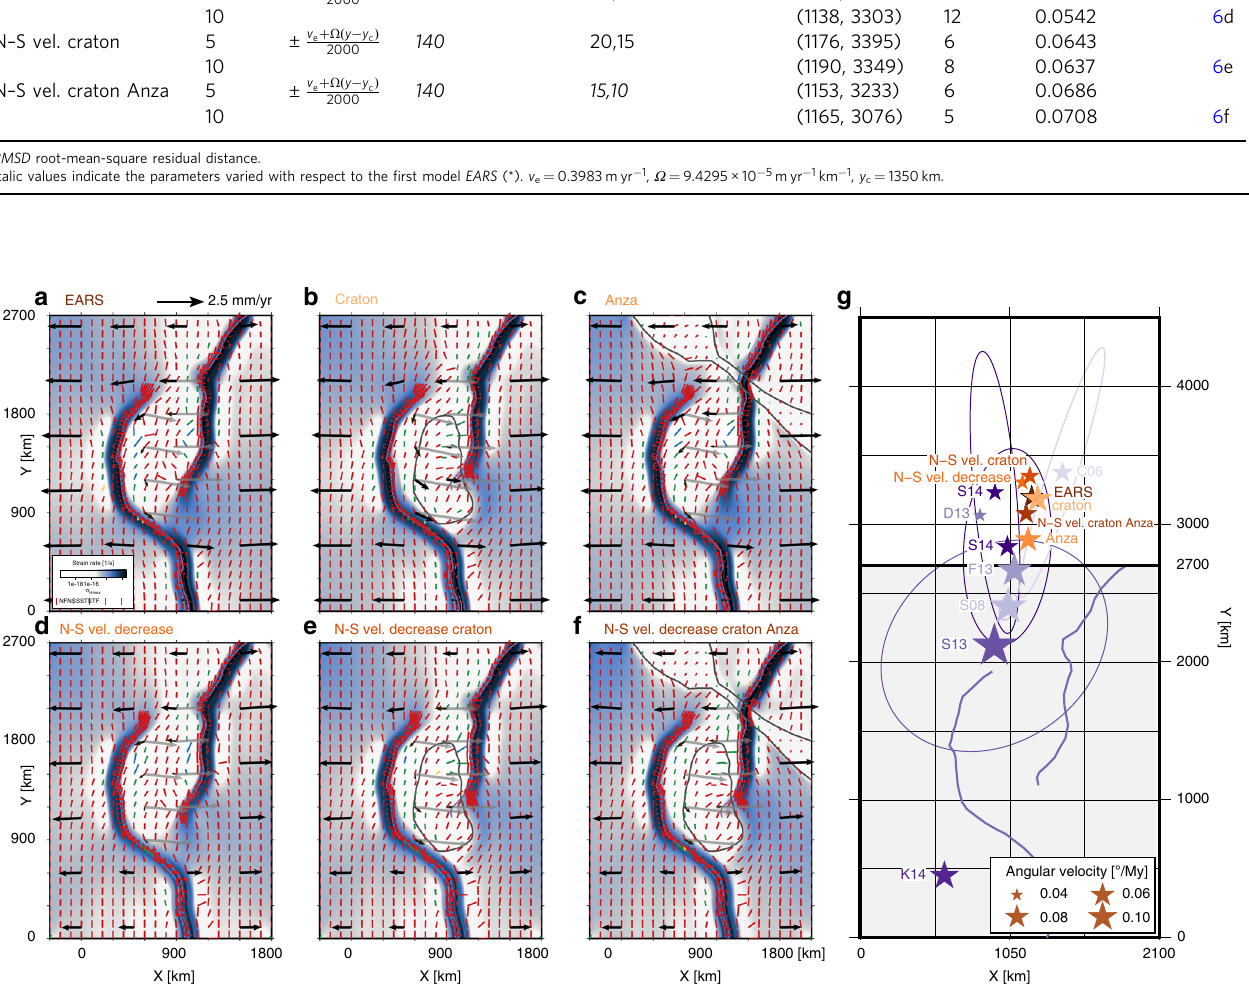
Fig. 6 Controlling factors of the East African Rift System-speci fi c mobile belt con fi guration model. a – f Depicted are the strain rate fi eld, maximum horizontal compressive stress σ colored according to the tectonic stress regime, and the velocity vectors at 3-km depth and 10 My for the East African Hmax Rift System initial mobile belt con fi guration models. Black vectors are plotted in the model frame of motion, while the dark-gray vectors represent the microplate motion in a Nubia- fi xed frame. Black and gray vectors are scaled equally. Tanzania craton and Turkana depression outlines are plotted in gray when used in the initial conditions. g In brown, the microplate rotation poles relative to the Nubian plate. Rotations poles from geodetic data inversion are included in purple, for references see the caption of Fig. 1a. The model domain is indicated in gray, and the mobile belt axes in purple. Details on each of the models are given in Table 2. NF normal faulting, NS normal and strike – slip faulting, SS strike – slip faulting, TS thrust and strike – slip faulting, TF thrust